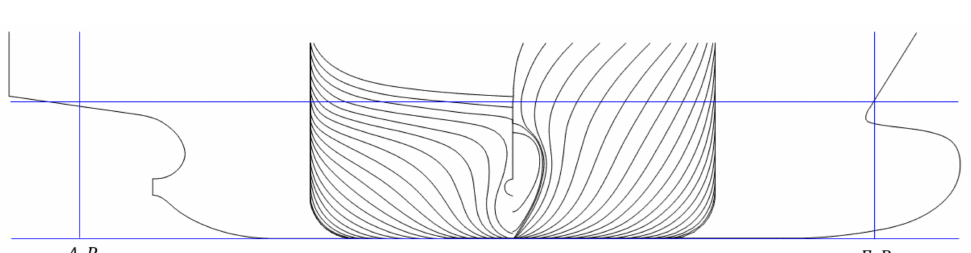
Figure 1. Body plan and side view of the initial hull form of the objective ship.